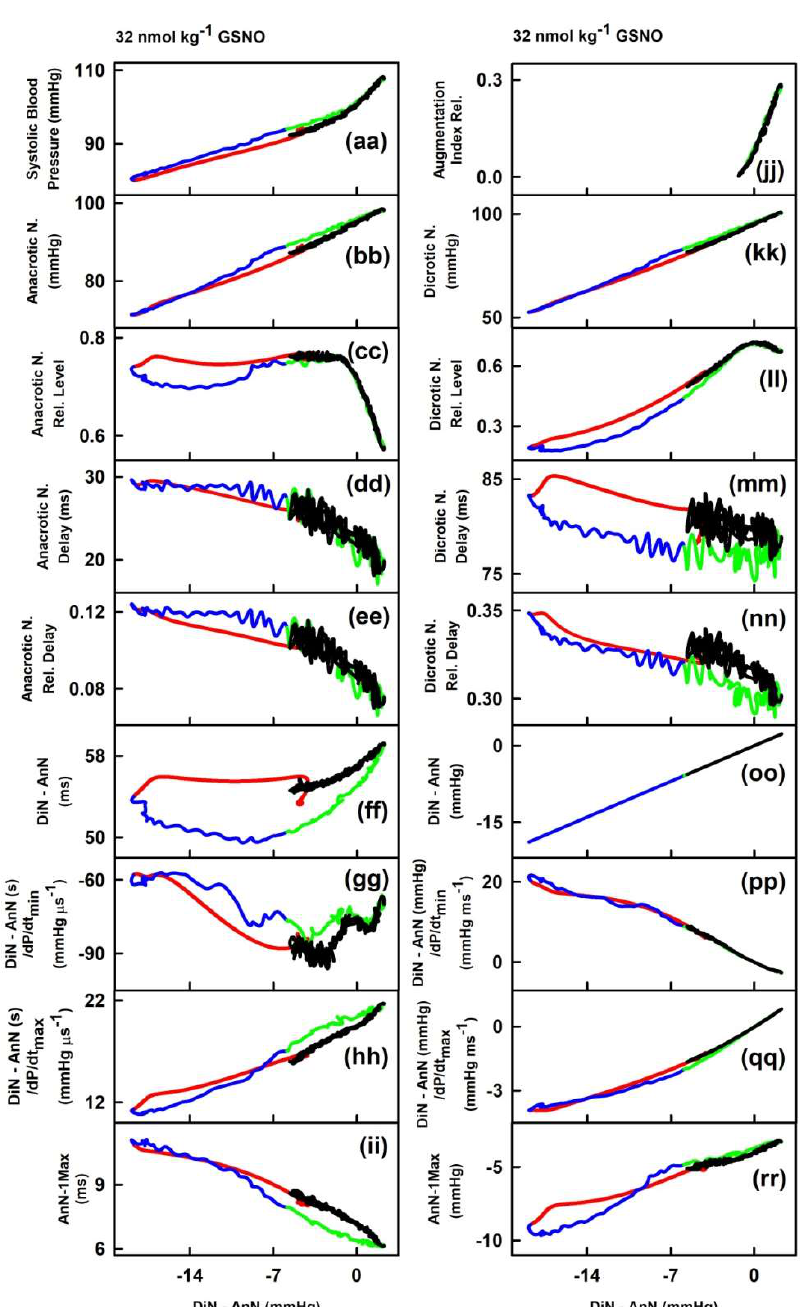
Figure 3. Two-dimensional relationships of HPs to the pressure interval between dicrotic (DiN) and anacrotic (AnN) notches after the administration of 32 nmol·kg –1 GSNO. The colors and time-dependent data correspond to Figure 2. Time period corresponding to the decrease of systolic BP (red), increase of systolic BP to the control value (blue), further increase of systolic BP to maximum (green), and decrease of systolic BP to the control value (black). The hysteresis was arbitrary defined as HPs-(DiN-AnN in mmHg) loop > 5 mmHg of DiN-AnN. The non-hysteresis was arbitrary defined as HPs-(DiN-AnN in mmHg) loop ≤ 5 mmHg of DiN-AnN. The non-hysteresis two-dimensional relationships were observed between (DiN-AnN in mmHg) and systolic BP (a), dP/dt max (d), dP/dt max -RL (e), dP/dt d -RL (g), dP/dt d –dP/dt min in s (i), diastolic BP (j), pulse BP (k), dP/dt min (m), dP/dt min -RL (n), dP/dt d –dP/dt max in mmHg (q), anacrotic notch (bb), anacrotic notch delay (dd), anacrotic notch rel. delay (ee), DiN-AnN/dP/dt min (gg), DiN-AnN/dP/dt max (hh), AnN-1Max (ii), dicrotic N. (kk), (DiN-AnN)/dP/dt min (pp) and